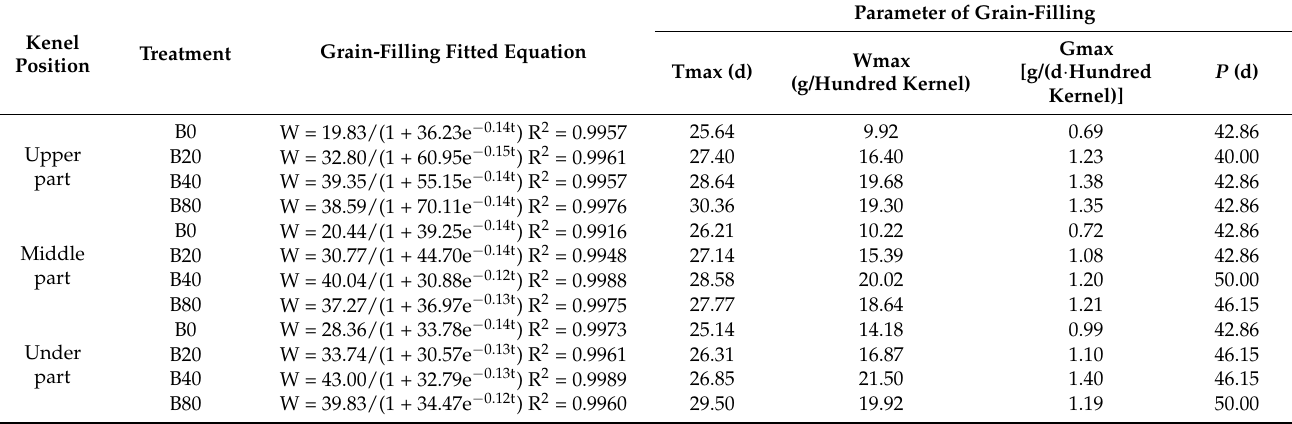
Table 4. Maize grain-filling fitted equation and the grain-filling parameters.